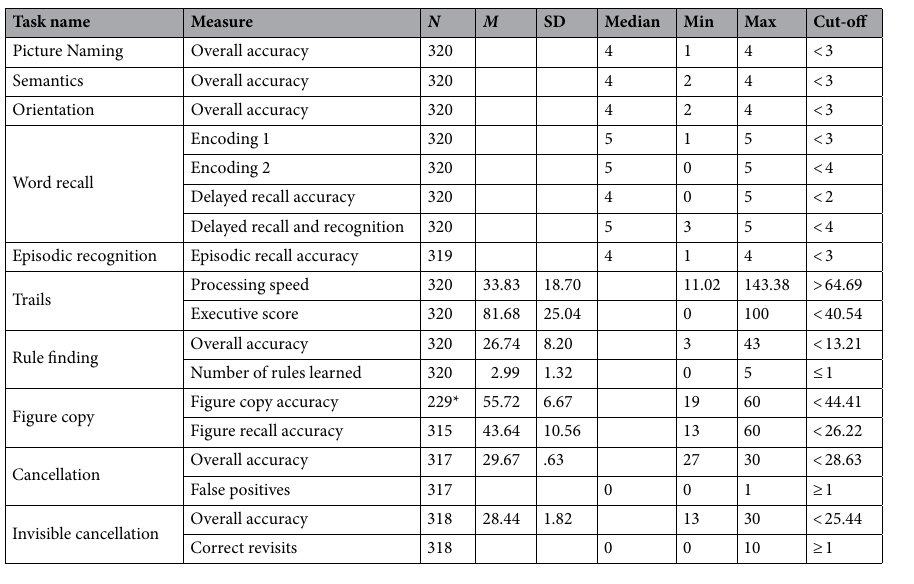
Table 3. Data and cut offs for impairment (z-scores greater than 1.65 SD from the mean or scores lower than 5th centile) for OCS-Plus subtasks. Oxford Cognitive Screen-Plus (OCS-Plus). Means and SDs reported only for tasks with sufficient range in values. We proposed to use Z-score based impairments greater than 1.65 SDs from the mean for tasks with larger ranges of possible scores (measures from Trails, Rule finding and Figure copy tasks, as well as Cancellation and Invisible Cancellation accuracy). Measures with small ranges of possible scores are reported as median, and 5th centiles are chosen from determining cut-offs for impairment (Picture Naming, Orientation, Semantics, Word Recall, False positives, and correct revisits). Centiles for number of rules learned, false positives, and correct revisits were conservatively increased to greater than or equal to one as the centile was 0 on each measure. Asterisks reflect UK only normative